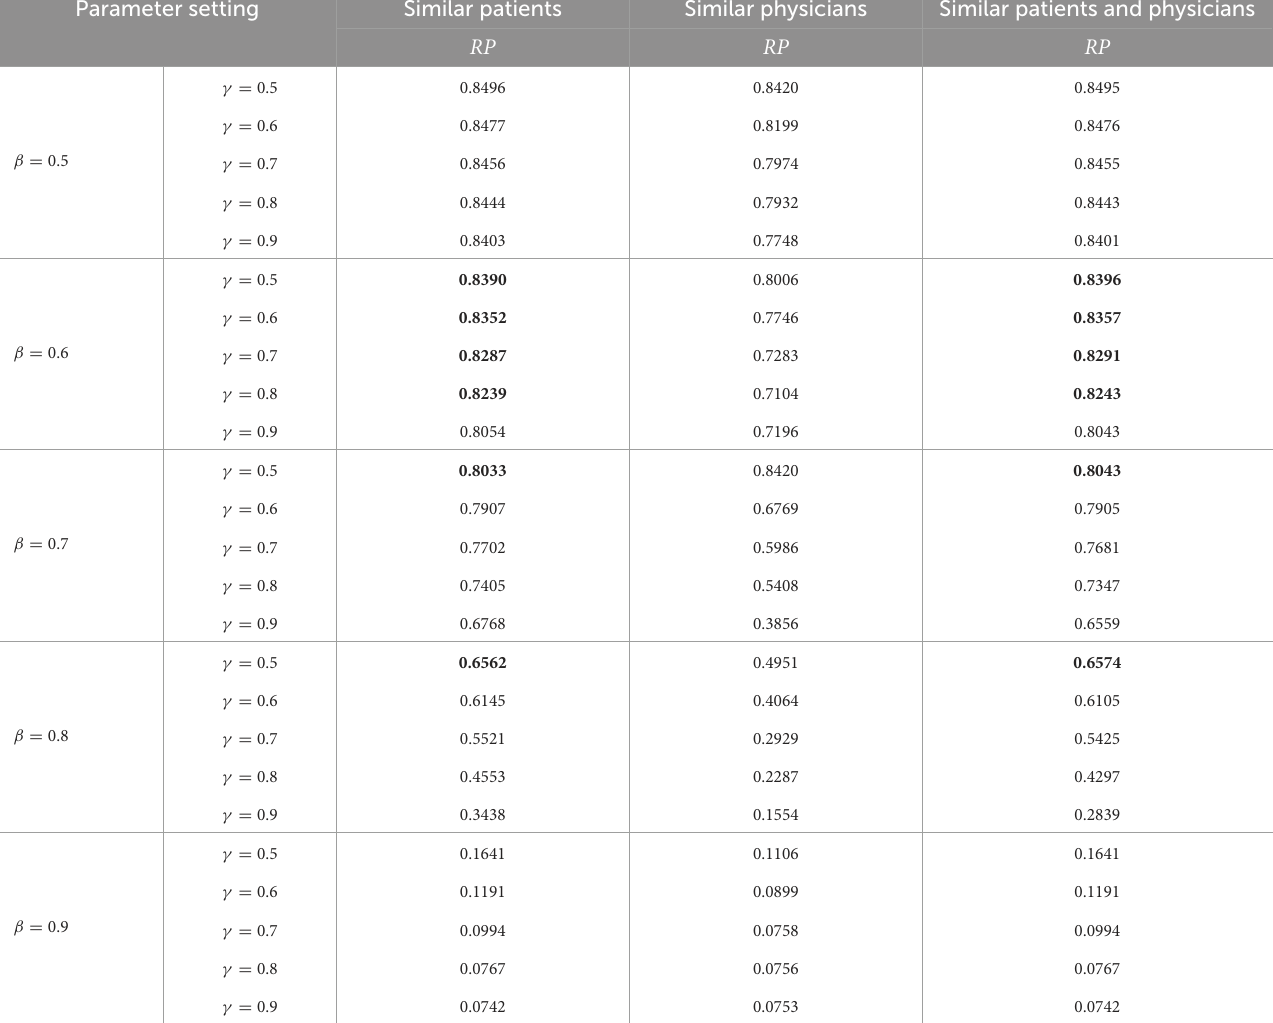
TABLE 15 Recommendation performance of three recommendation models under different parameters. Parameter setting Similar patients Similar physicians Similar patients and